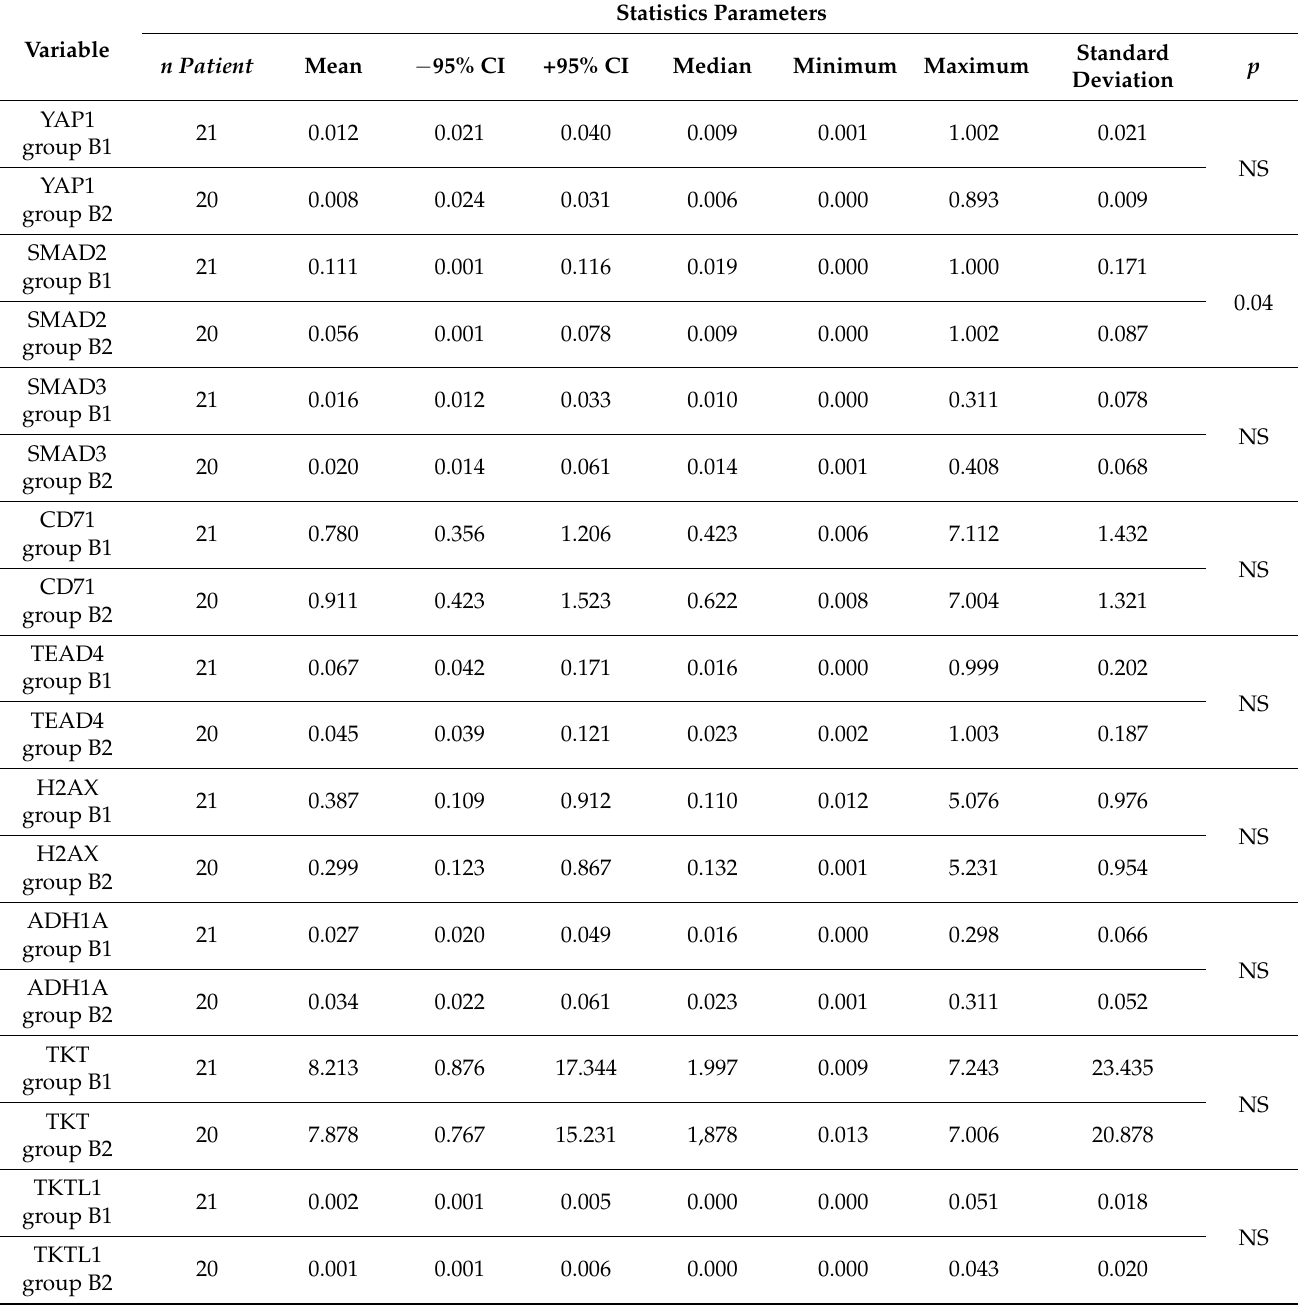
Table 4. Statistic parameters; group B1: simple cyst and group B2: normal